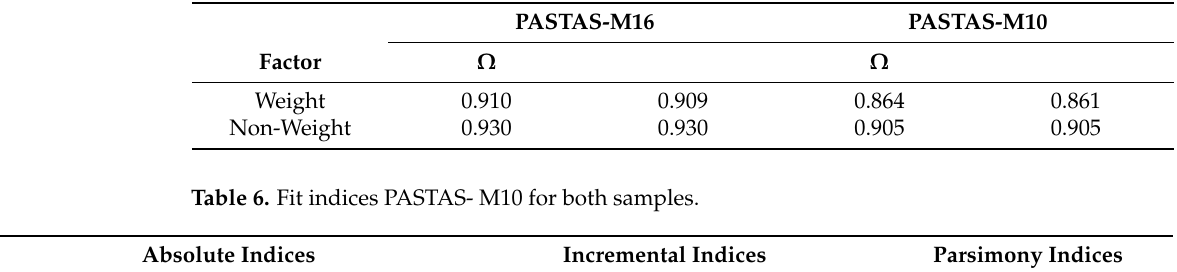
Table 5. Omega and alpha coefficients for the factors from PASTAS-M16 and PASTAS-M10 models.